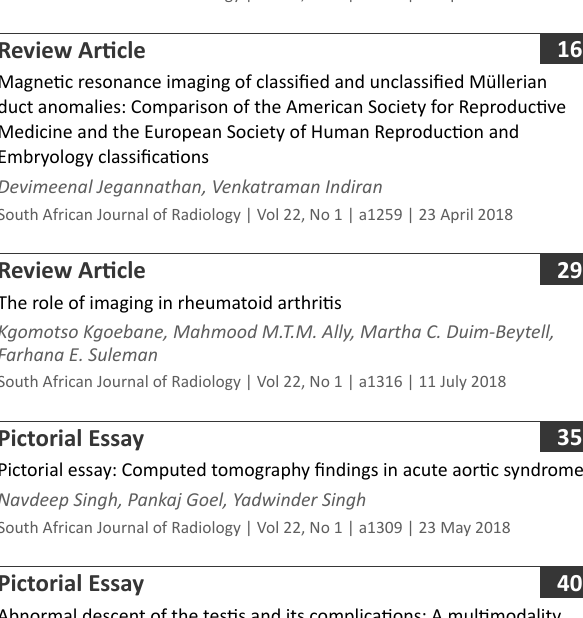
Abnormal descent of the testis and its complications: A multimodality imaging